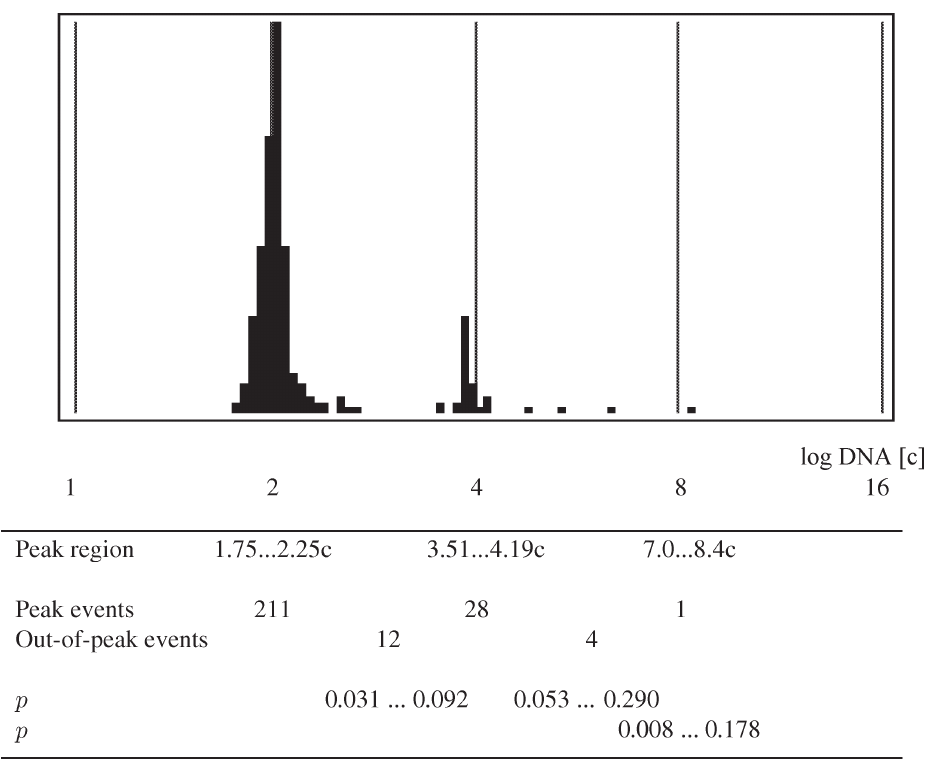
Fig. 9. DNA histogram with out-of-peak events. The regions of the stemline (99.5% of the cells belonging to the stemline) and its polyploidizations are shown with the actual numbers of events and their probabilities of